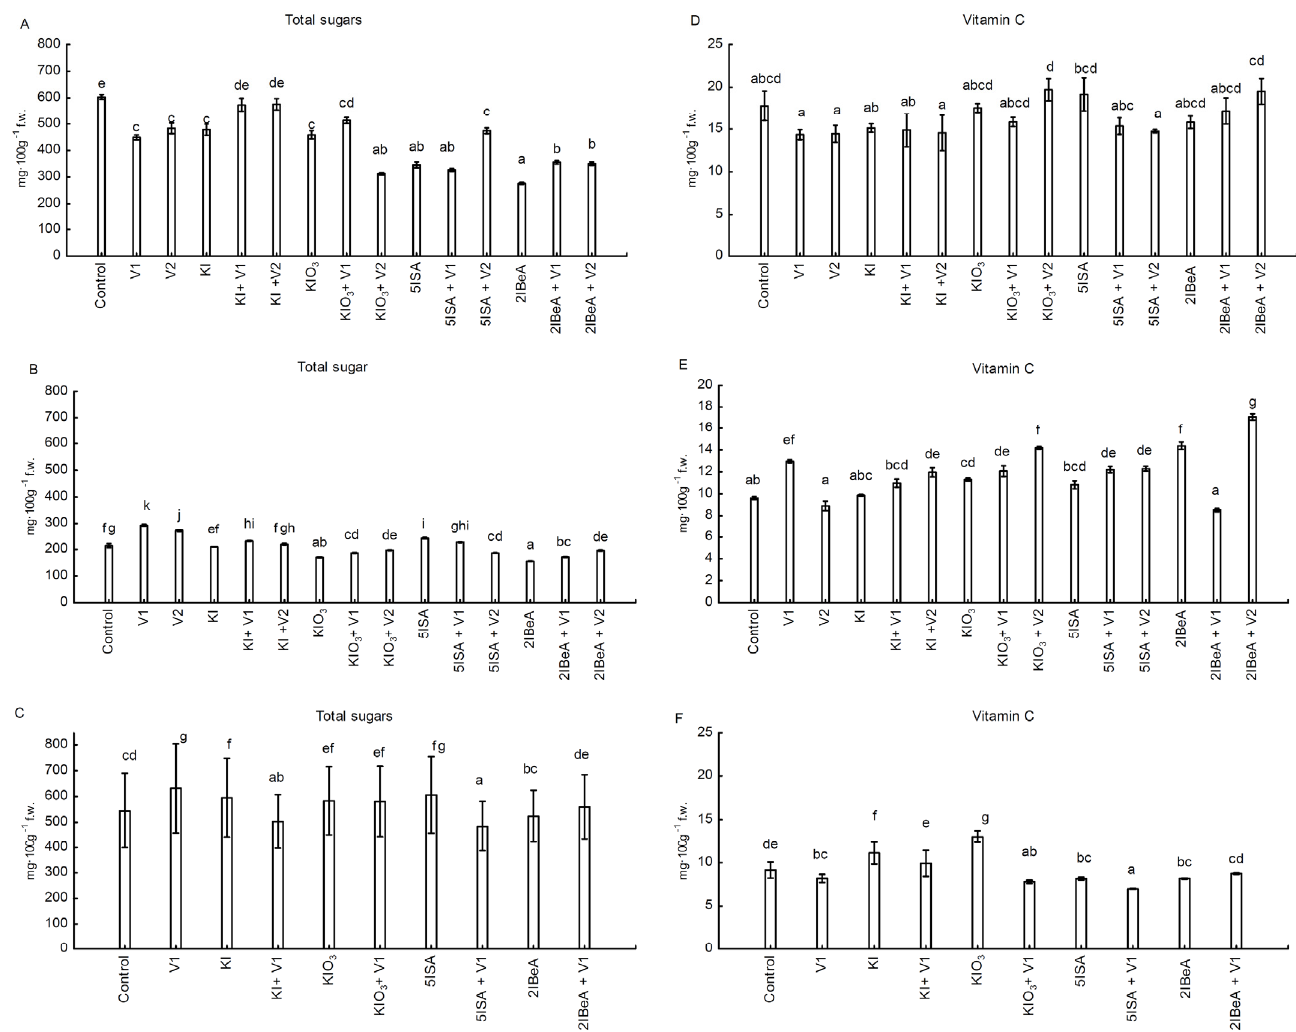
Figure 4. Content of total sugars in grain from experiment No.1 ( A ), No.2 ( B ) and No.3 ( C ), as well as ascorbic acid content in in grain from experiment No.1 ( D ), No.2 ( E ) and No.3 ( F ). Means followed by different letters for treatments differ significantly at p < 0.05 ( n = 8). Bars indicate standard error.